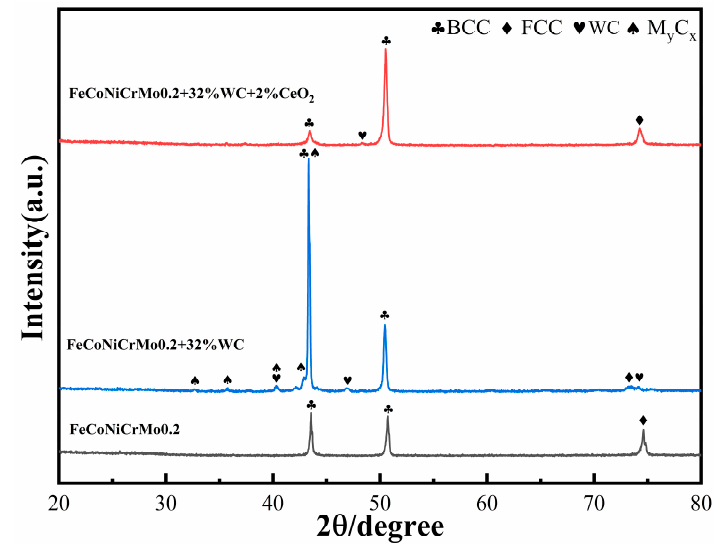
Figure 4. XRD pattern of three coatings.